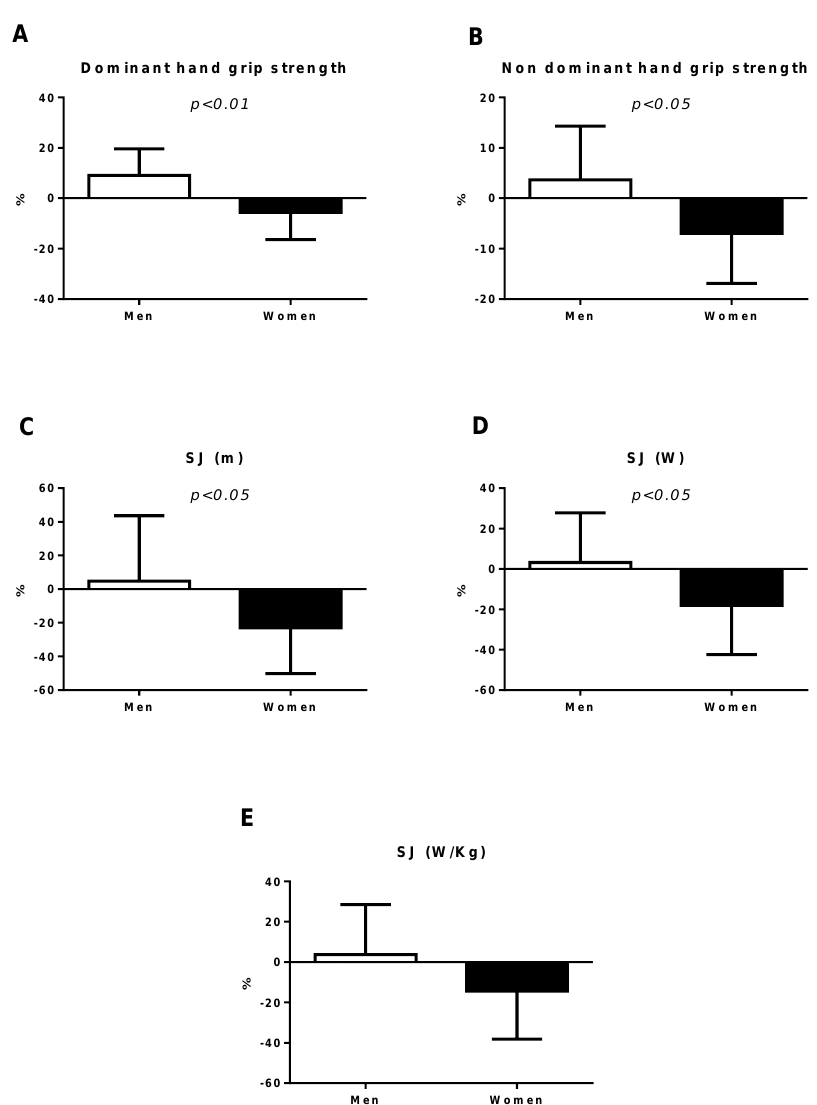
Figure 1. The percentages of change in the hand grip strength and neuromuscular parameters: ( A ) The percentage of change in the dominant hand grip strength; ( B ) the percentage of change in the non-dominant hand grip strength; ( C ) the percentage of change in SJ; ( D ) the percentage of change in the SJ watts; ( E ) the percentage of change in the watts in relation to body weight SJ; SJ: squat jump.